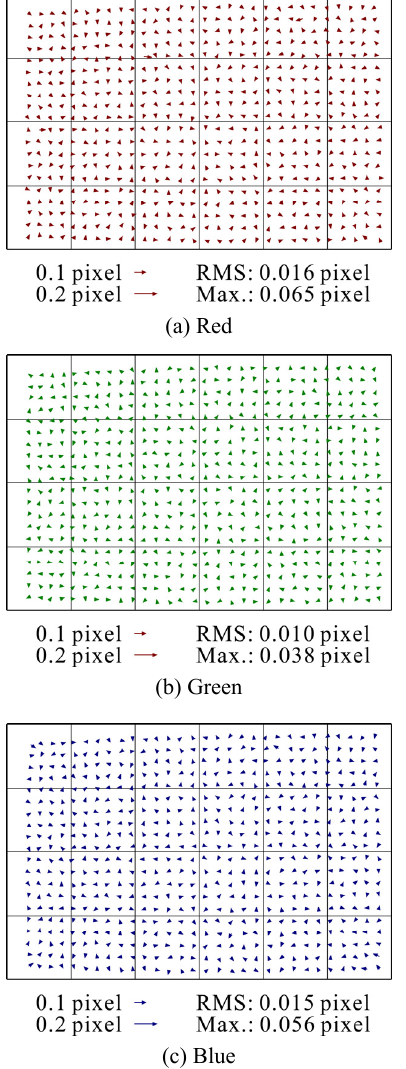
Figure 10. Displacement vectors caused by lossy JPEG compression with 2x2 1x1 1x1